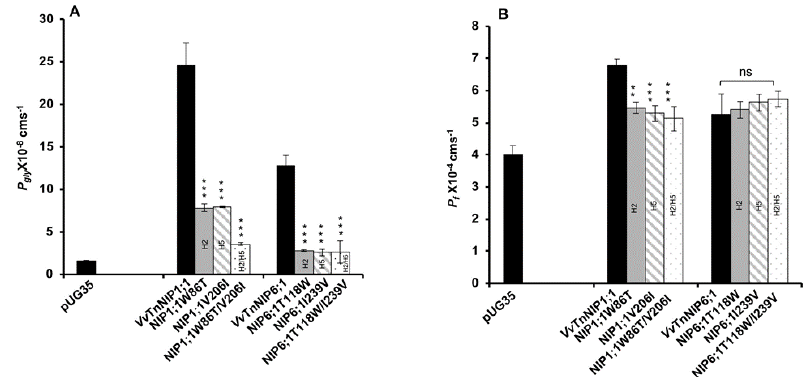
Figure 3. Effect of point mutation in the ar/R selectivity filter of grapevine VvTnNIP1;1 and VvTnNIP6;1 on ( A ) glycerol ( P gly ), ( B ) water ( P f ), and permeability coefficients. The permeabilities were measured in yeast strains expressing functional grapevine NIPs, and their mutants in H2, H5, and H2/H5 helices. Cells expressing empty vector pUG35 were considered as a negative control. Data represent the mean ± SD of three independent experiments with ten technical replicates. Statically significance differences are shown as an asterisk, calculated by t -test (** p < 0.01 and *** p < 0.001); no significant differences are shown as ns.